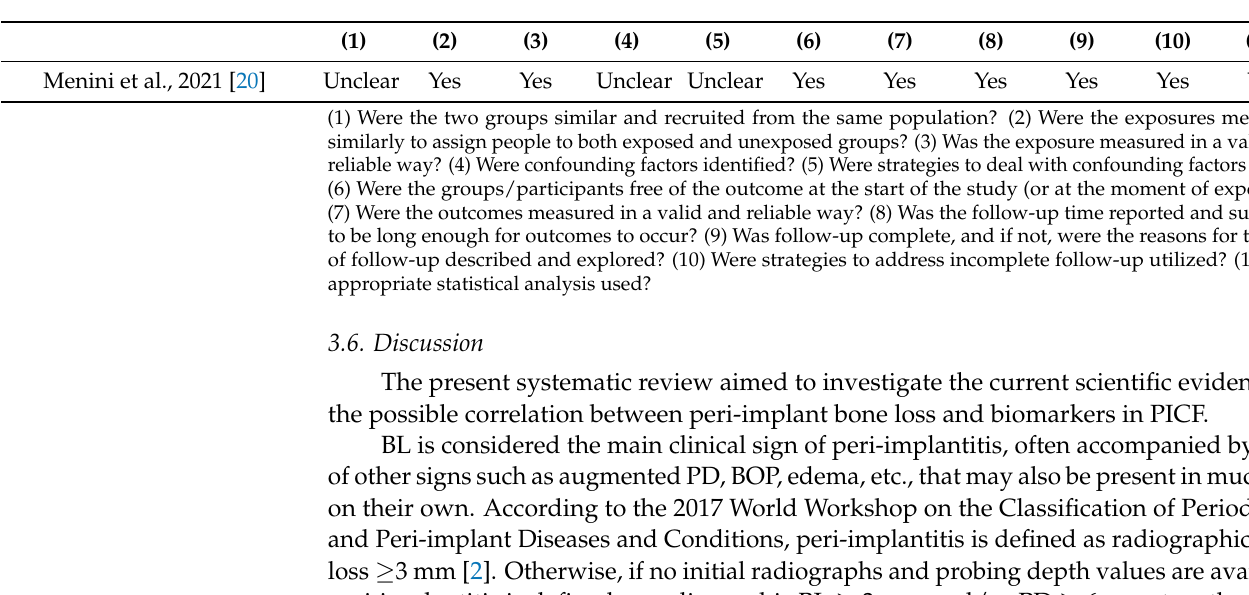
Table 3. Risk of bias for clinical studies included in the present systematic review according to the critical appraisal tools of the JBI Scale for Cohort